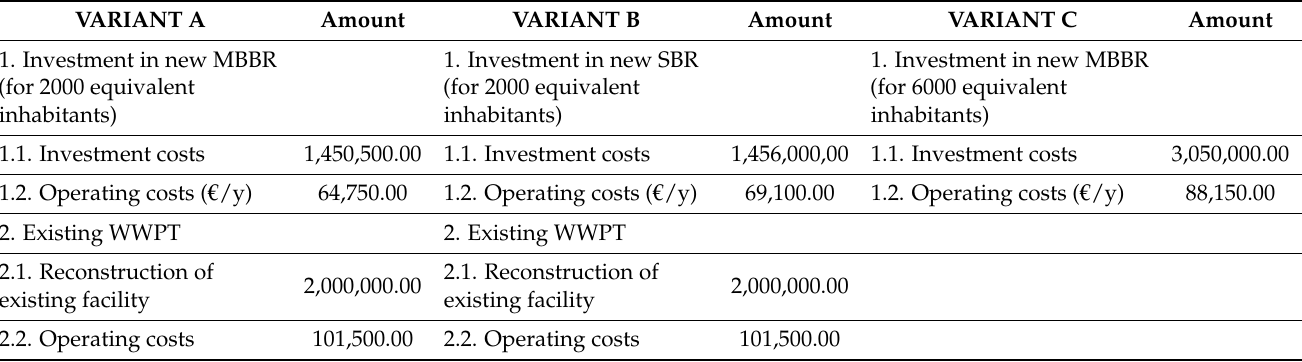
Table 1. Estimated investment and operating costs for variants A, B, and